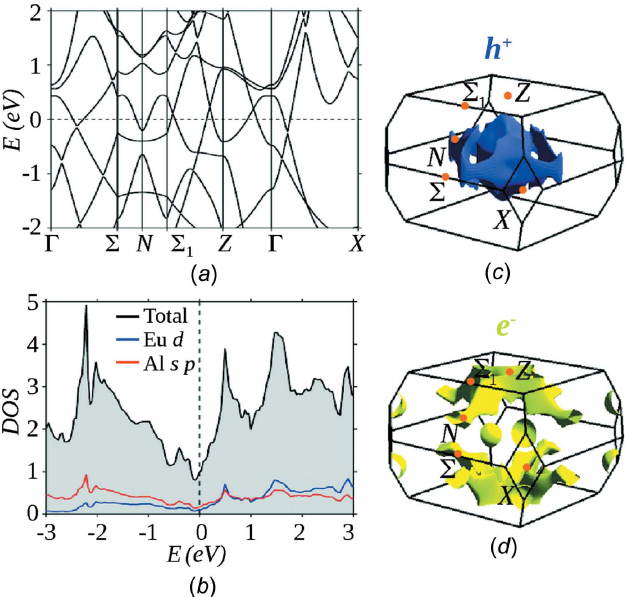
Figure 4 ( a ) Bulk band structure and ( b ) density-of-states (DOS) of EuAl 4 . The dashed lines in parts ( a ) and ( b ) mark the Fermi level at energy ( E ) zero. The calculated ( c ) hole (blue) and ( d ) electron (yellow) Fermi pockets in